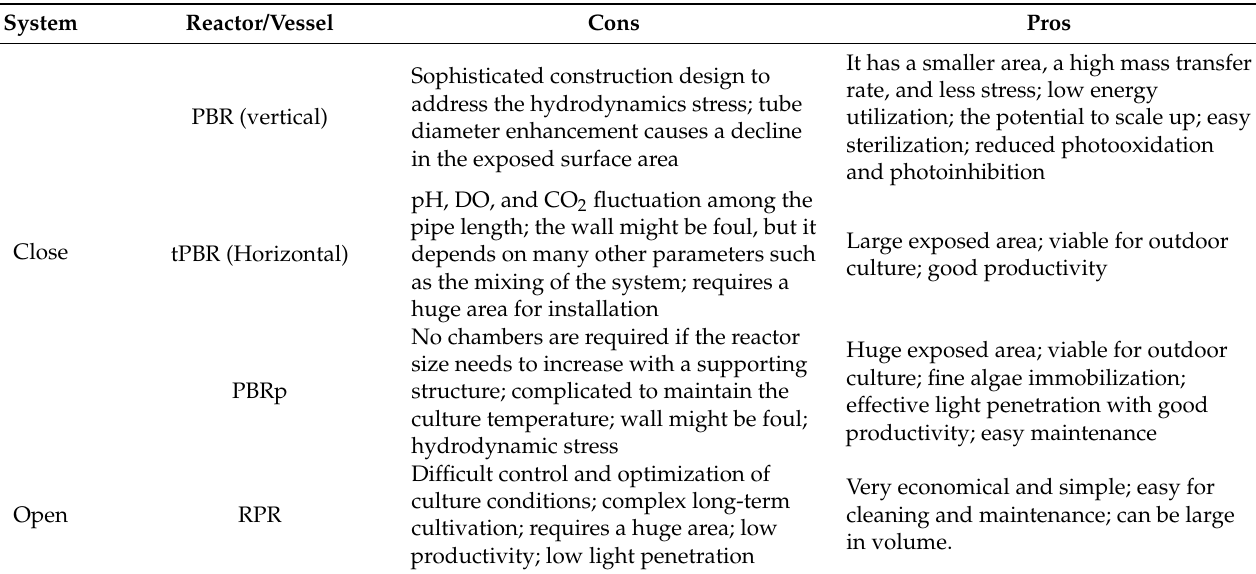
Table 1. Comparison of different microalgae cultivation